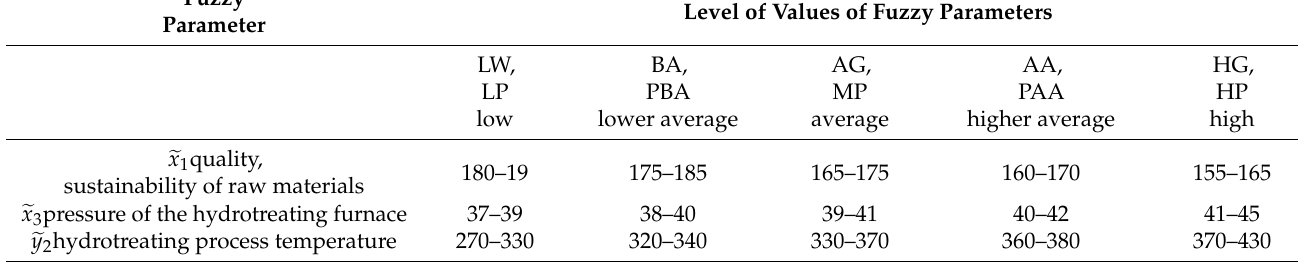
Table 2. Universums for fuzzy parameters (cid:101) x 1 , (cid:101) x 3 and (cid:101) y 2 .